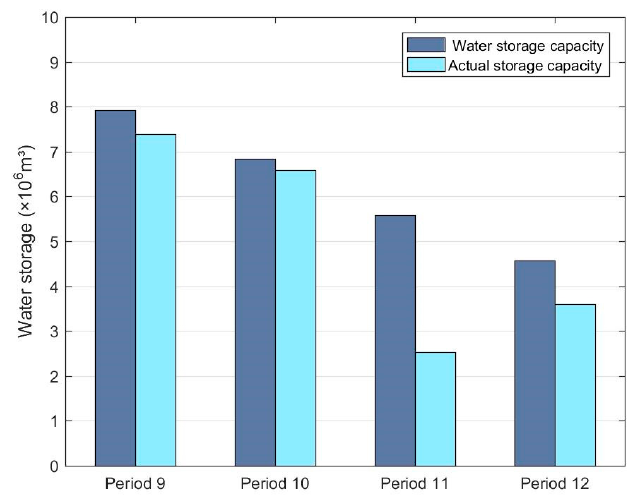
Figure 15. Water storage capacity during the hedge period 9–12.